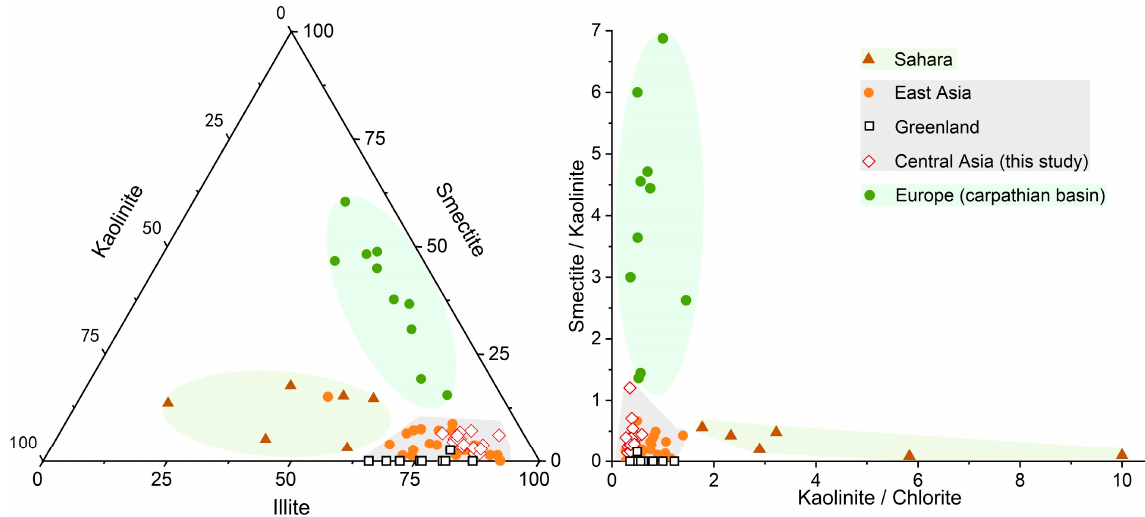
Figure 4. Comparison of clay minerals in different regions of the Northern Hemisphere. (Data sources: Sahara—Svensson et al. (2000) [80], Guerzoni et al. (1997) [81]; East Asia—Peng (2004) [82], Gylesjo and Arnold (2006) [83], Leinen et al. (1994) [84], Svensson et al. (2000) [80]; Greenland—Biscaye et al. (1997) [85]; Europe—Fu et al. (2021) [60], Újvari et al. (2012) [86], Varga et al. (2011) [87], Martinez-Lamas et al. (2020) [88]).